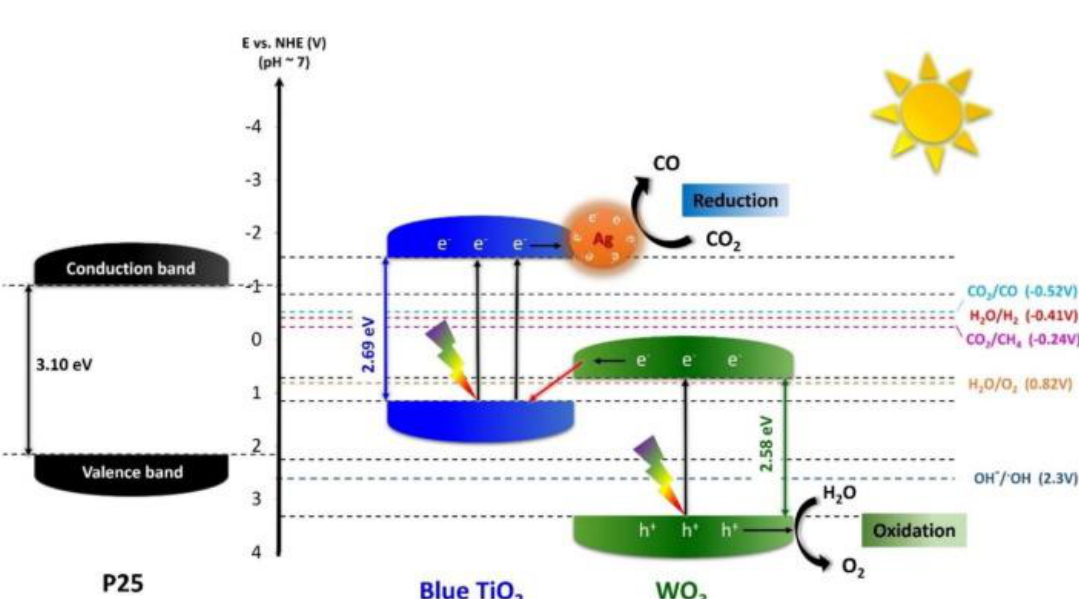
Figure 15. Band alignments of P25 and blue TiO 2 NPs and the proposed electron transfer mechanism of the 7BT/W1–A1 HNPs photocatalyst. The photoelectrons generated and excited electrons from the CB of WO 3 to migrate to trap holes at the VB of blue TiO 2 sites through a Z-scheme system. After separation, the excited electrons rapidly jump from the CB of blue TiO 2 onto Ag NPs acting as active sites for conversion of CO 2 into CO, while all of the photogenerated holes directly oxidize H 2 O to form O 2 from the VB of the WO 3 site. Reproduced from [91] . Copyright (2019) Elsevier.